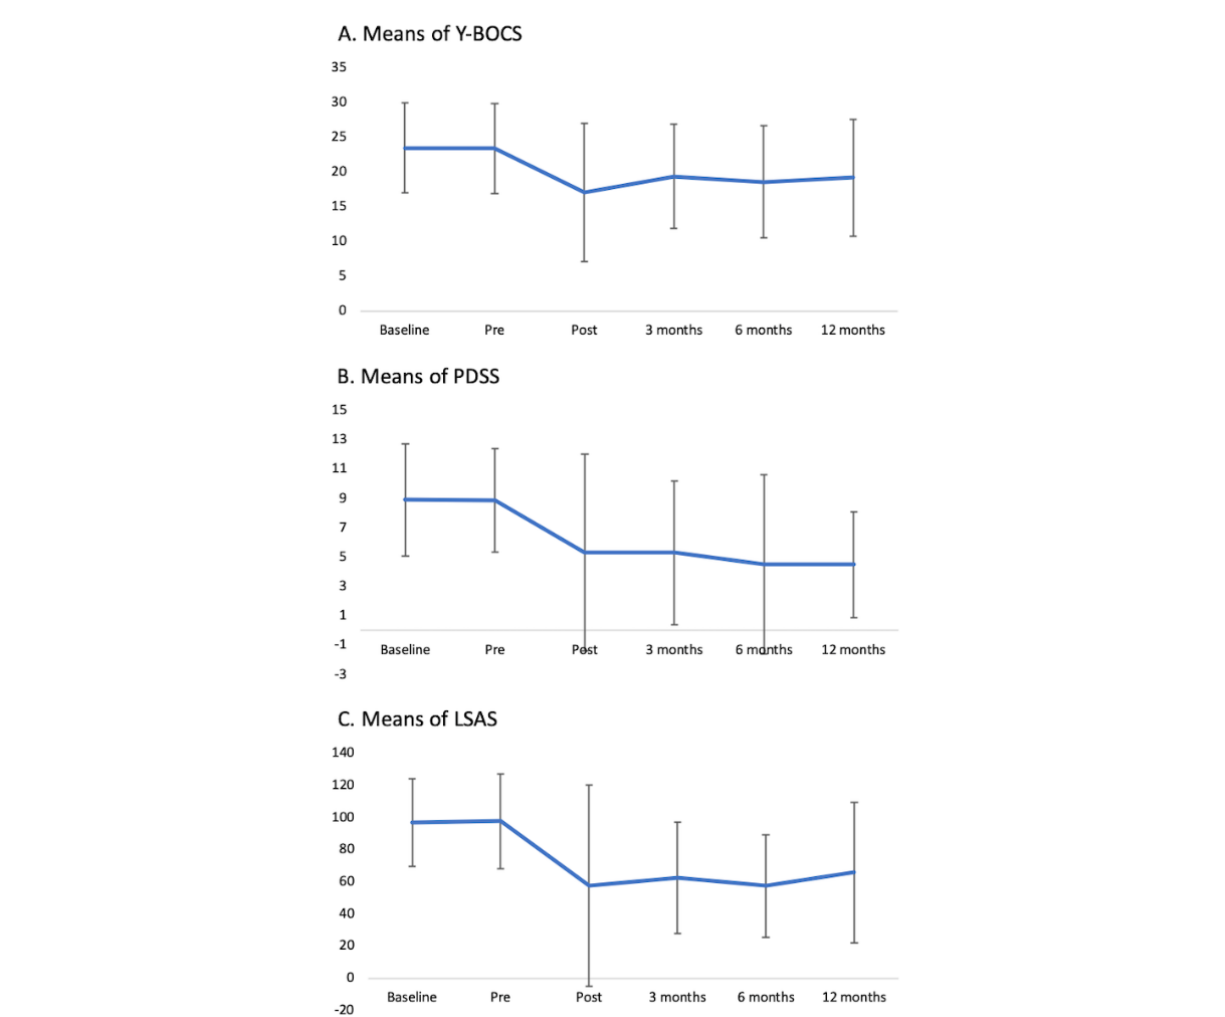
Figure 2. Participants’changes in